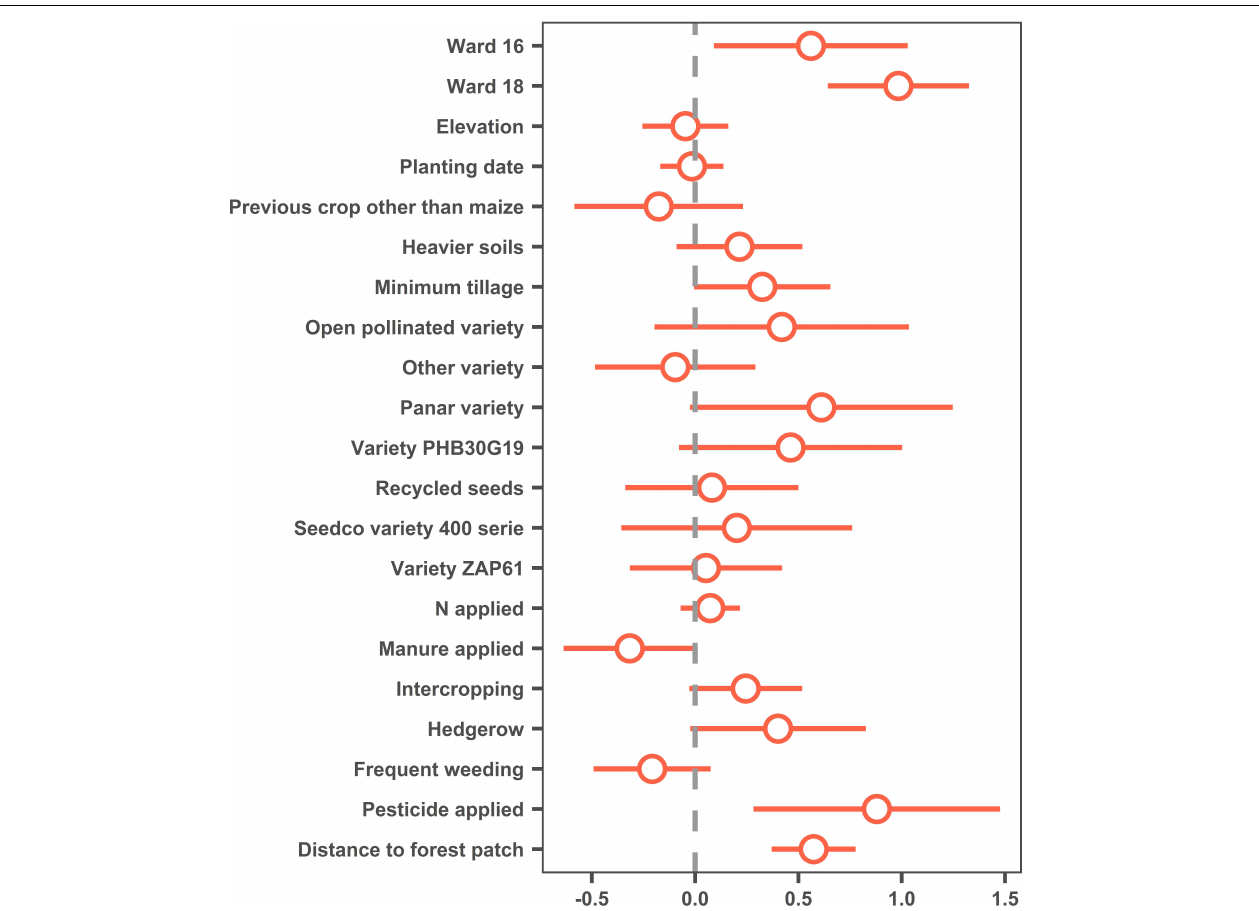
FIGURE 2 | Dotwhisker plot representing estimates (dots) and 95% confidence intervals (whiskers) for a generalized linear models with a logit distribution. Whiskers crossing the y -axis (gray dotted line) indicate non-significance for the corresponding factor. “Ward 20,” “maize as previous crop,” “conventional tillage,” “Seedco variety 500 serie,” “no manure applied,” “no intercropping,” “no hedgerow,” “infrequent weeding (none or one)” and “no pesticide applied” were used as control in the